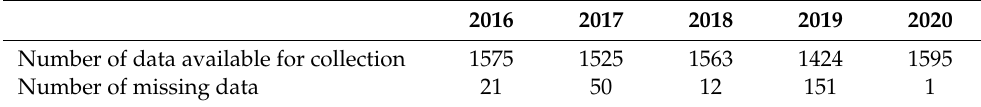
Figure 1. Distribution map of Wuhan City environmental monitoring sites. Table 1. Summary of data collection